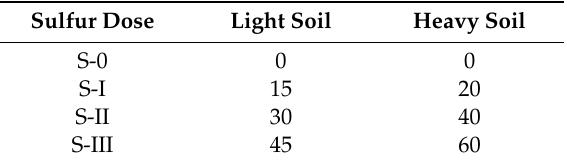
Table 2. Doses of sulfur introduced to the soils (mg kg − 1